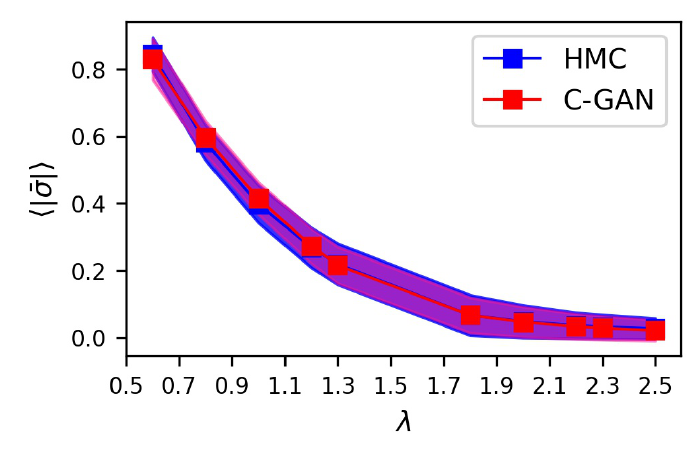
Figure 4: Mean 〈| ¯ σ |〉 and standard deviation on λ obtained via HMC and C-GAN.